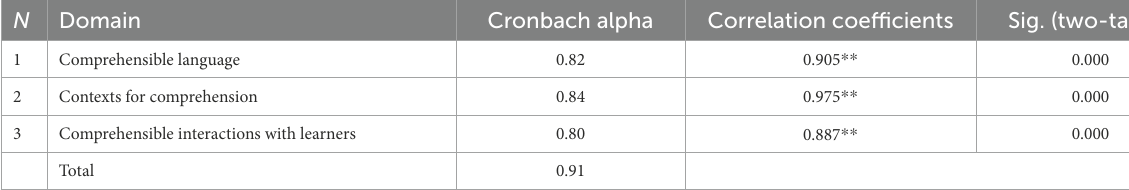
TABLE 4 Pearson correlation coefficients for domains and scale.